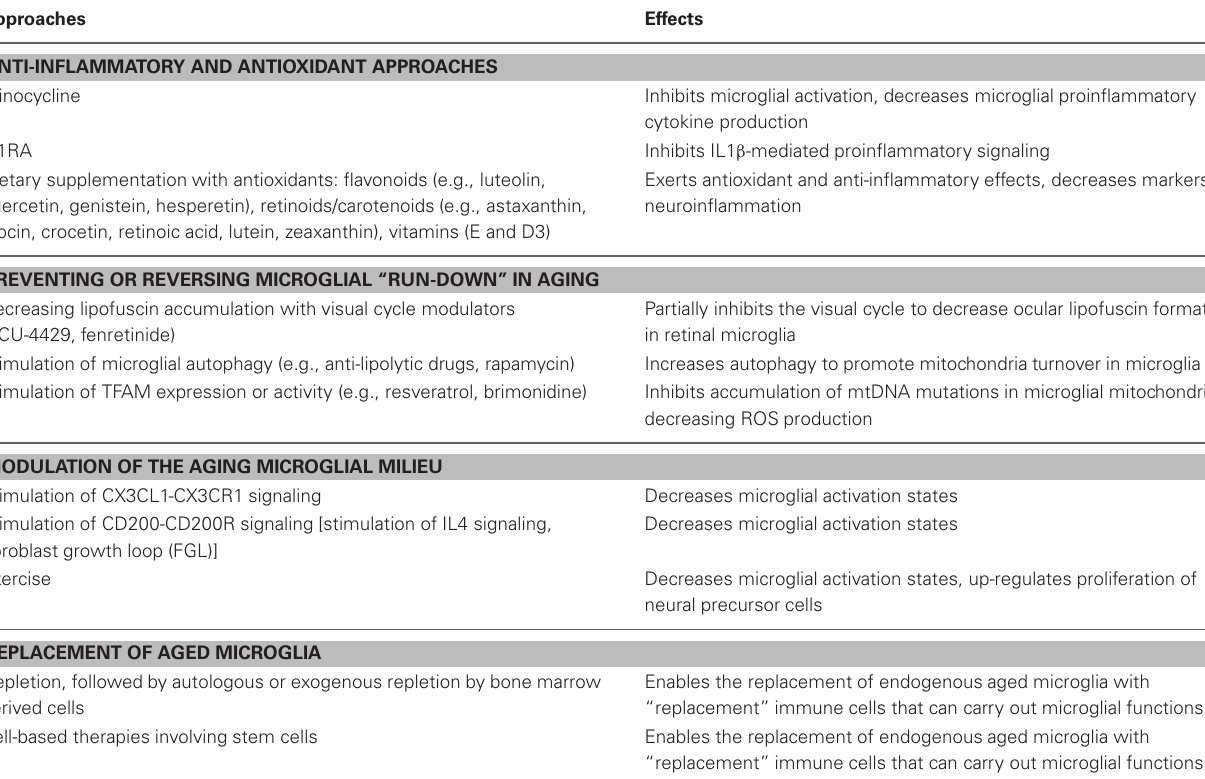
Table 3 | Proposed therapeutic approaches for the rejuvenation of senescent microglia.